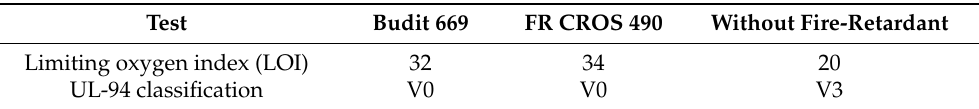
Table 2. Results for oxygen index measurements and UL-94 tests. For UL-94 tests, profile segments in 13 mm width (100 mm profile length) were used.